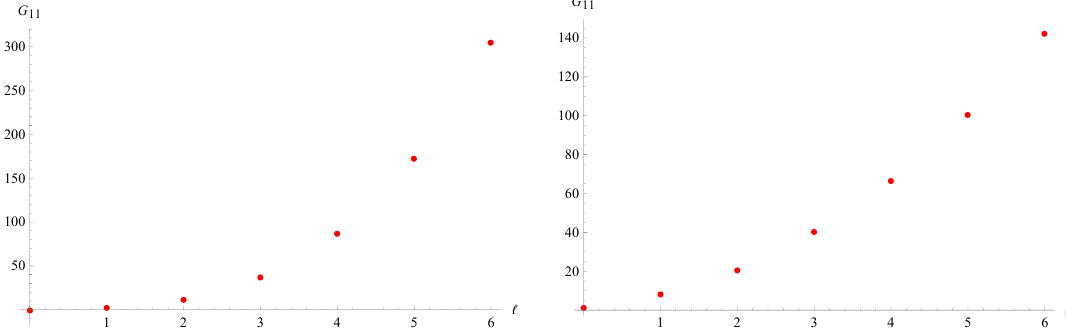
Figure 6 . The potential 1 = cn 2 u , where the periodicity is shown explicitly.